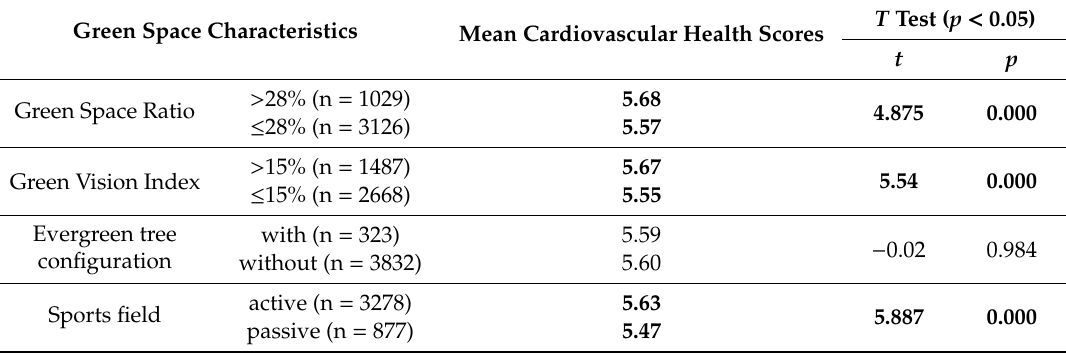
Table 5. Comparison of mean cardiovascular health scores of respondents by green space